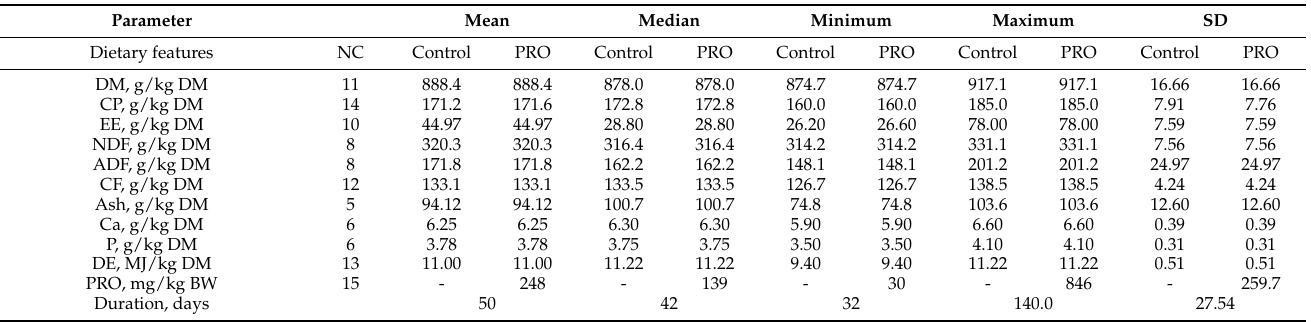
Table A2. Descriptive statistics of the complete data set for the effect of PRO supplementation to rabbits’